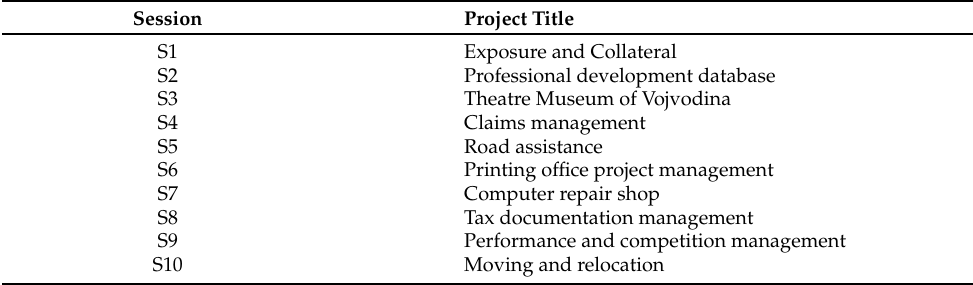
Table 5. Development sessions’ application